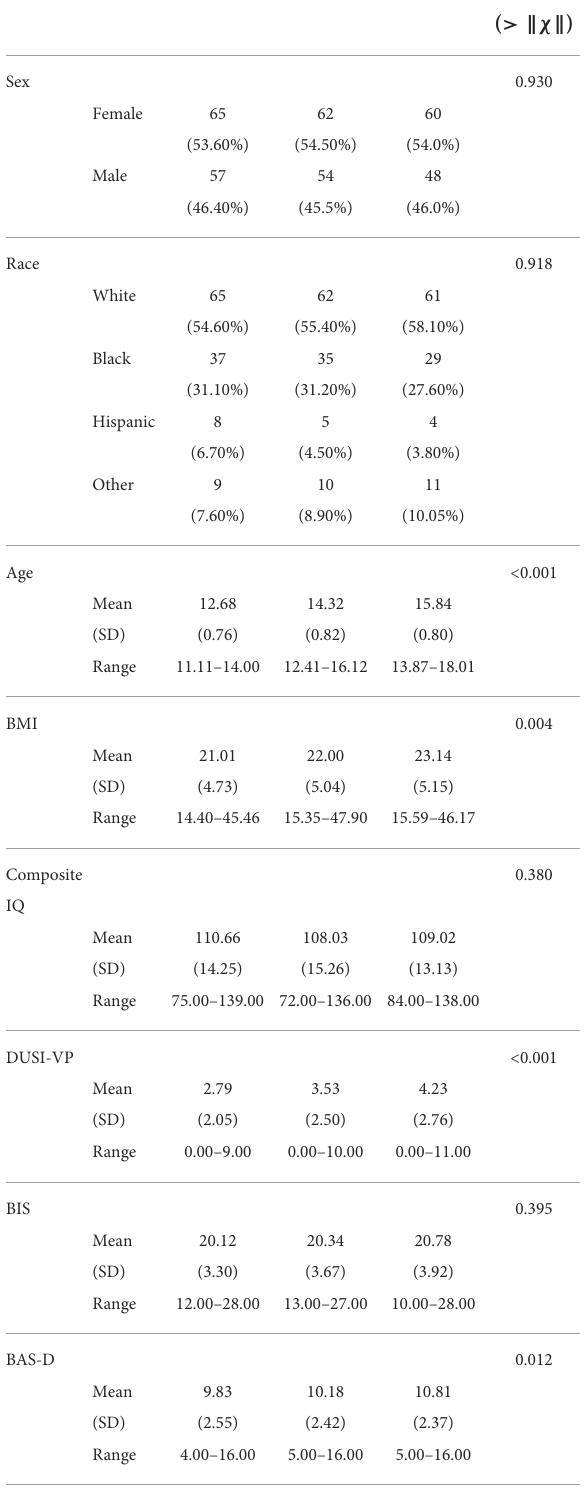
TABLE 1 Demographic, risk, and neuropyschological indicators assessed across